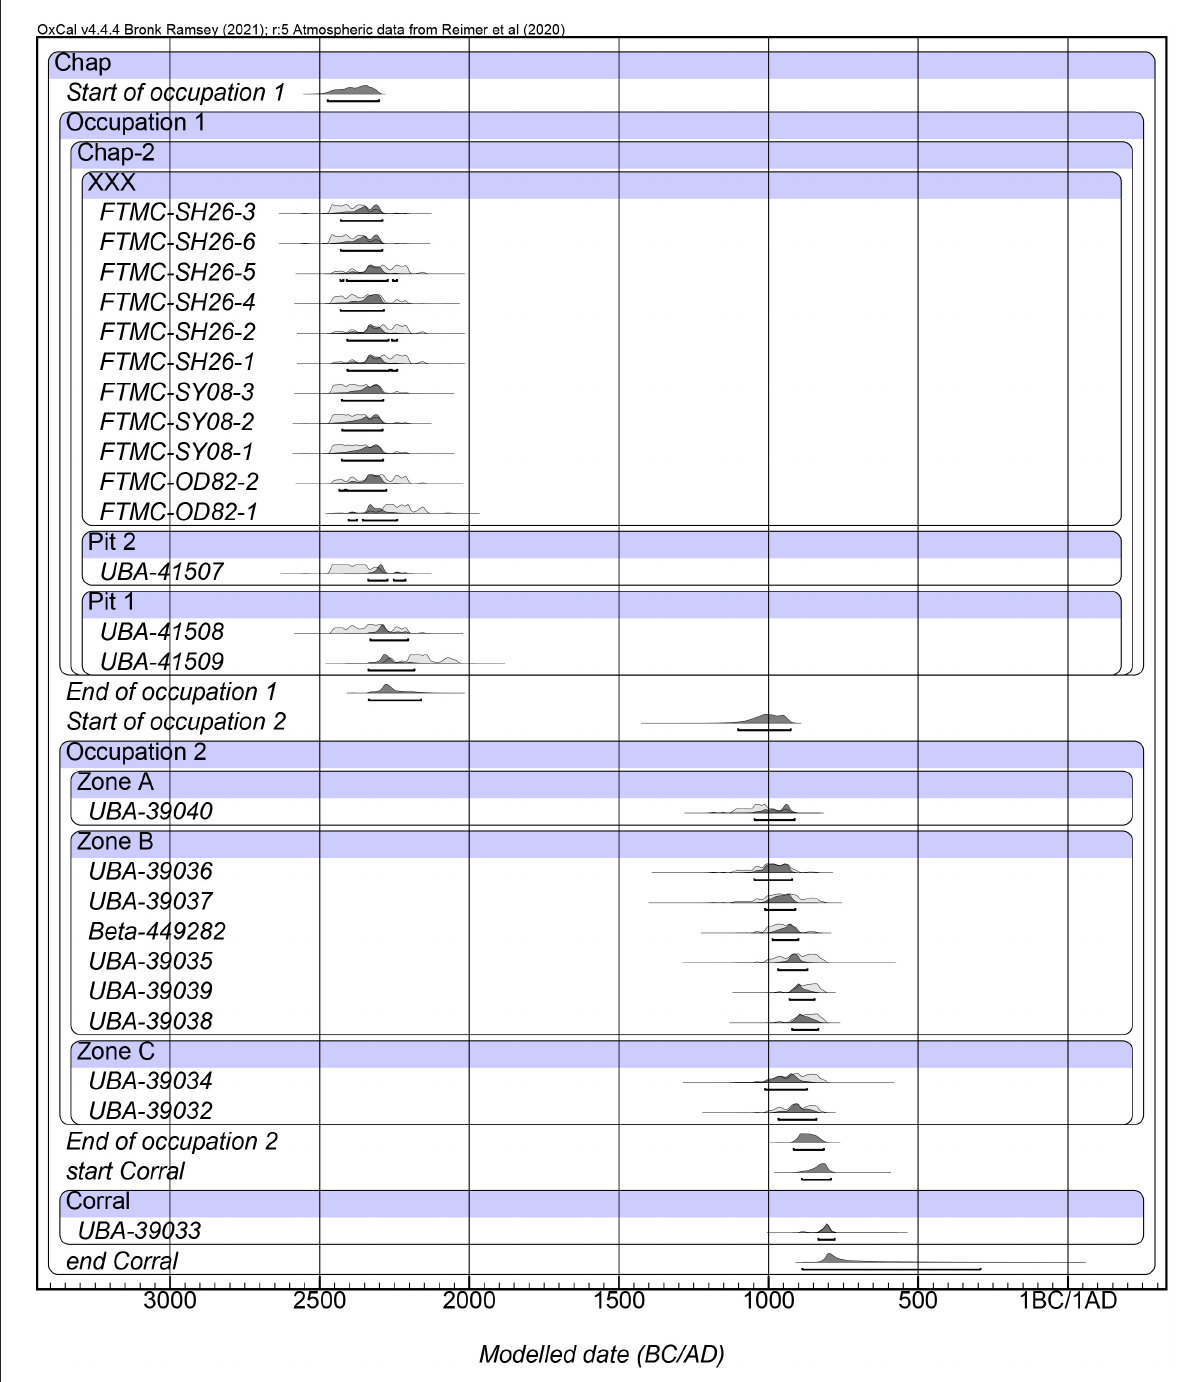
FIGURE9 Radiocarbon chronology for Chap II. Modeled radiocarbon dates measured on plant seeds, human, and faunal bone from Chap II in relation to the later occupational period of Chap I. Three AMS dates from Chap II and all dates from the Chap I site were previously published (Motuzaite Matuzeviciute et al.,